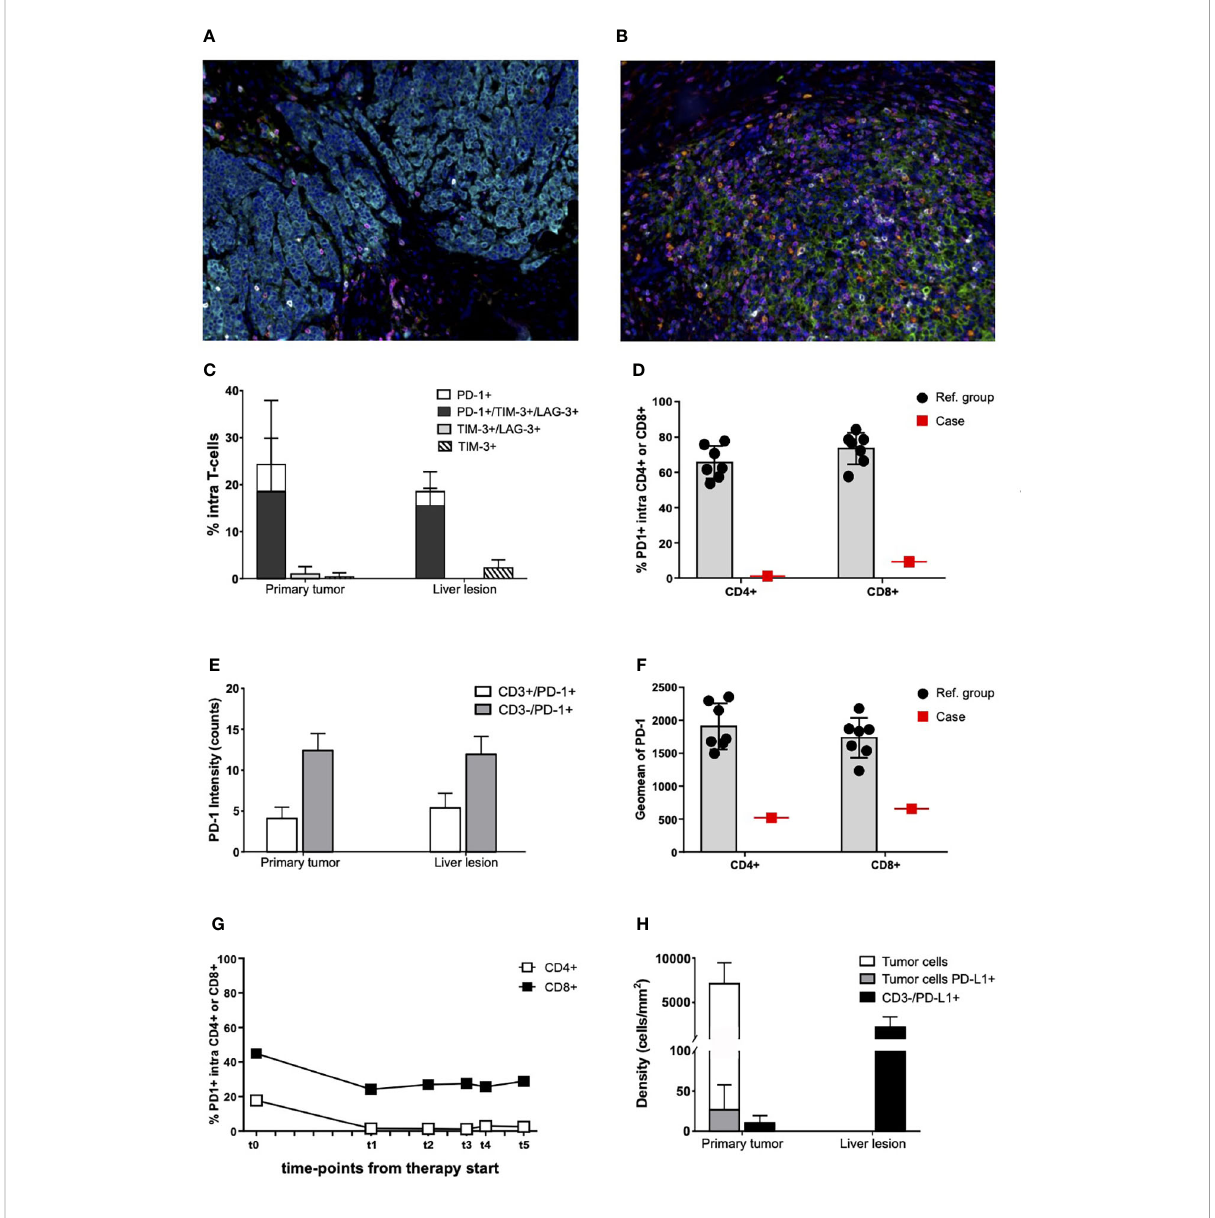
FIGURE 4 Immune checkpoint expression in primary tumor, liver lesion, and PBMCs. (A, B) Representative seven-color mIHC images of immune checkpoint expression in PT (A) and in LL (B) ; staining antibodies of “ panel 4 ” : CD3 (magenta), PD-1 (white), PD-L1 (green), TIM-3 (yellow), LAG- 3 (red), pan-cytokeratin (cyan), and nuclei (blue). Original magni fi cation, ×20. (C) Percentages of PD-1 – , TIM-3 – , and LAG-3 – expressing T cells on total CD3+ cells in fi ltrating the PT and the LL, as assessed by mIHC. Mean values and SD are reported for each cell population. Data derived from analysis of 10 fi elds of each sample. (D) Percentages of PD1+ cells in fi ltrating fresh liver lesions from the patient (Case; red square) and from the reference group (Ref. group; black dots), as assessed by fl ow cytometry. Data are gated on CD4+ and CD8+ T cells. (E) mIHC analysis of PD-1 expression intensity on PD-1+ T cells (CD3+) and other PD-1+ cells (PD-1+/CD3 − ) in fi ltrating the PT and the LL. Mean values and SD are reported for each cell population. Data derived from analysis of the same 10 fi elds previously considered (C) . Intensity values are expressed in counts. (F) Flow cytometry data of PD-1 expression intensity (Geomean) on PD-1+ cells in fi ltrating fresh liver lesions from the patient (Case; red square) and the reference group (Ref. group; black dots). Data are gated on CD4+ and CD8+ T cells. (G) Percentages of PD-1 – expressing circulation T cells before therapy start (t0) and during treatment (t1 = disease re-staging after four cycles of immunotherapy, t2 = disease re- staging after six cycles of immunotherapy, t3 = disease re-staging after eight cycles of immunotherapy, and t4 = before surgical resection of the liver residual disease), as assessed by fl ow cytometry. Data are gated CD+ and CD8+ cells. (H) mIHC cell densities of PD-L1 – expressing cells in PT and LL. Mean values and SD are reported for each cell population. Data derived from analysis of the same 10 fi elds previously considered (C)